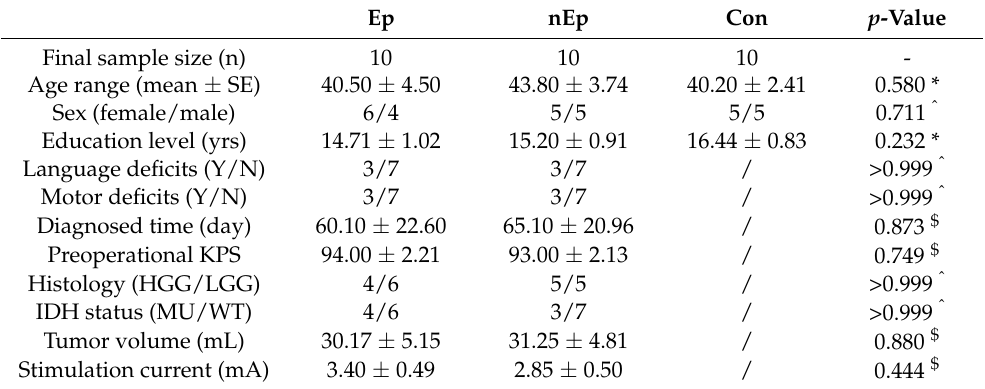
Table 1. Clinical characteristics of